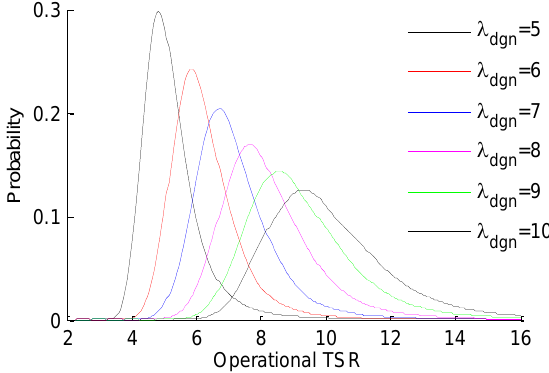
Figure 4. The probability distribution of operational tip speed ratio (TSR) corresponding to an array of λ dgn .